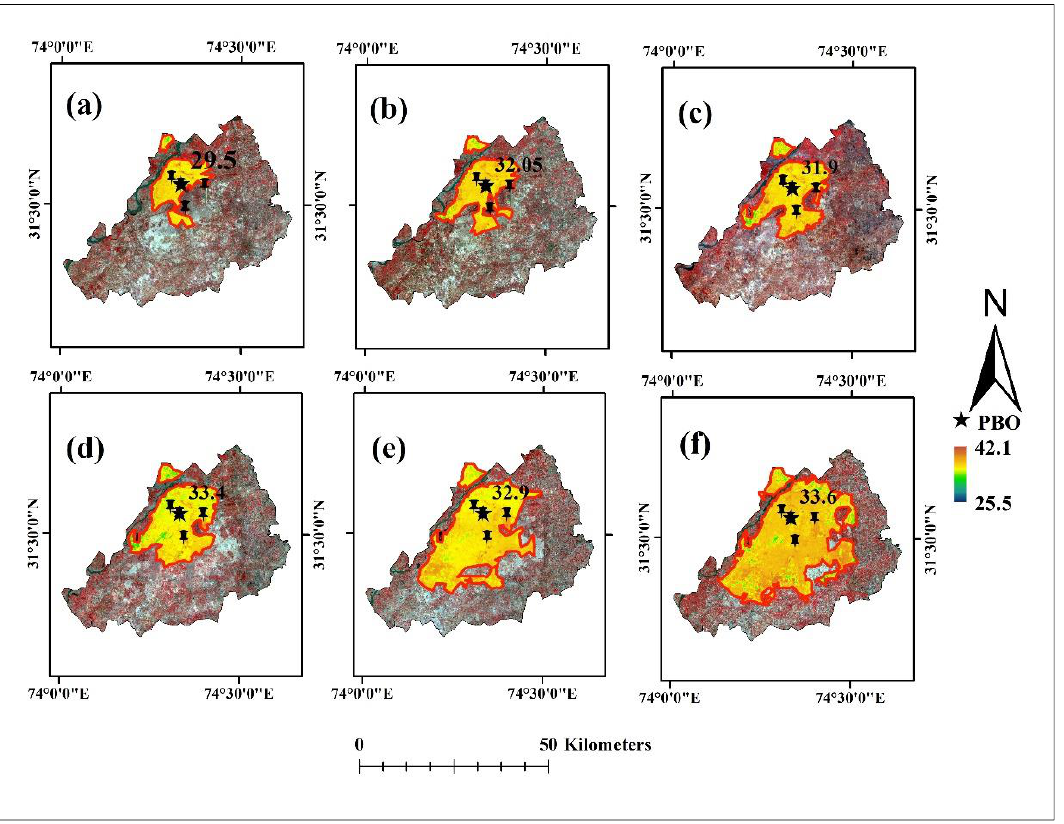
Figure 9. Expansion in Built-up land and LST in ( a ) 1992, ( b ) 1996, ( c ) 2000, ( d ) 2008, ( e ) 2014, ( f ) 2020. The symbol ( ) indicates the position of Pilot Balloon Observatory (PBO).